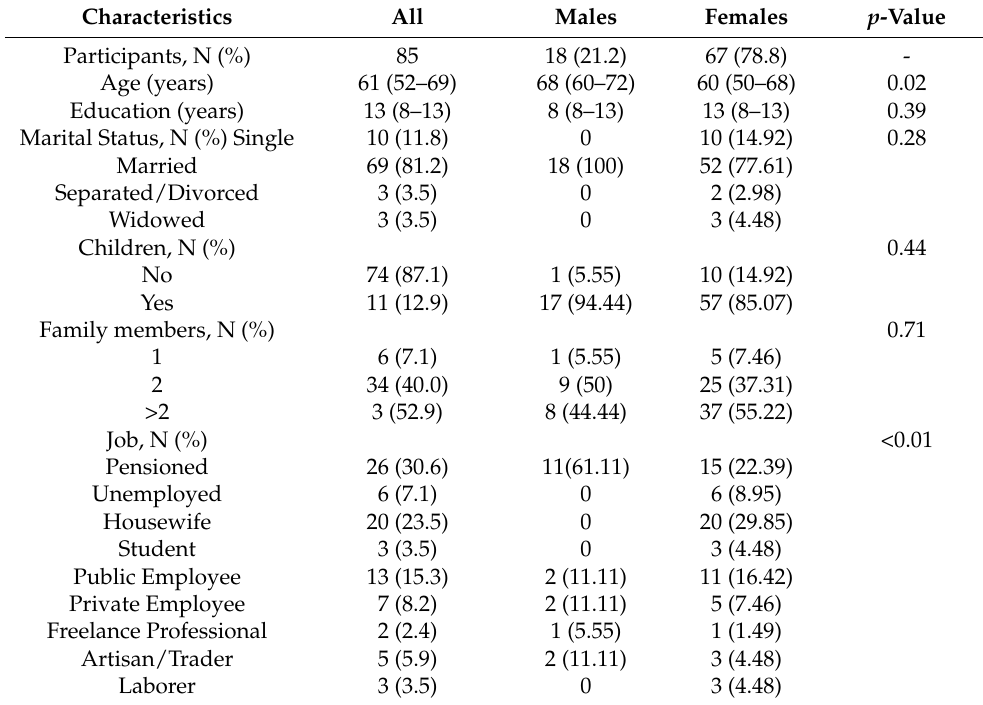
Table 1. Demographic characteristics of the cohort. Significant differences are in bold.